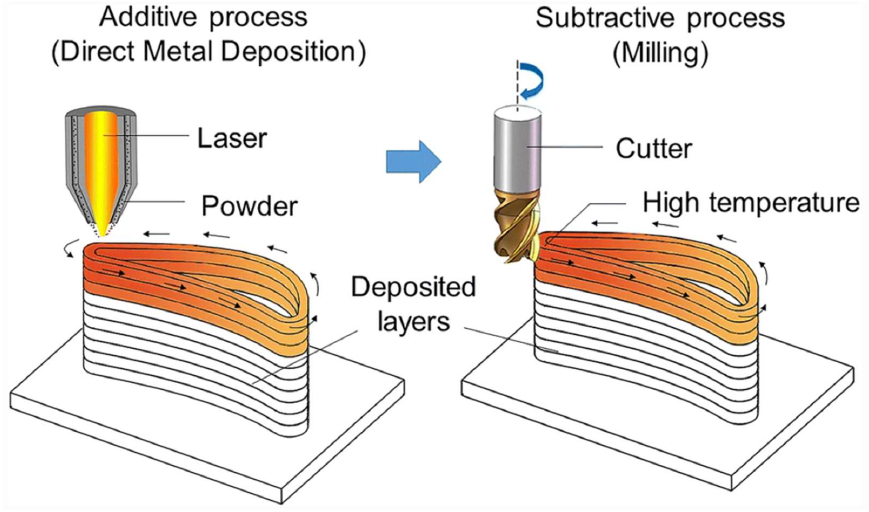
Figure 21. Additive and subtractive hybrid manufacturing processes [180] (Reprinted with permis- sion from [180]. Copyright 2020, Springer